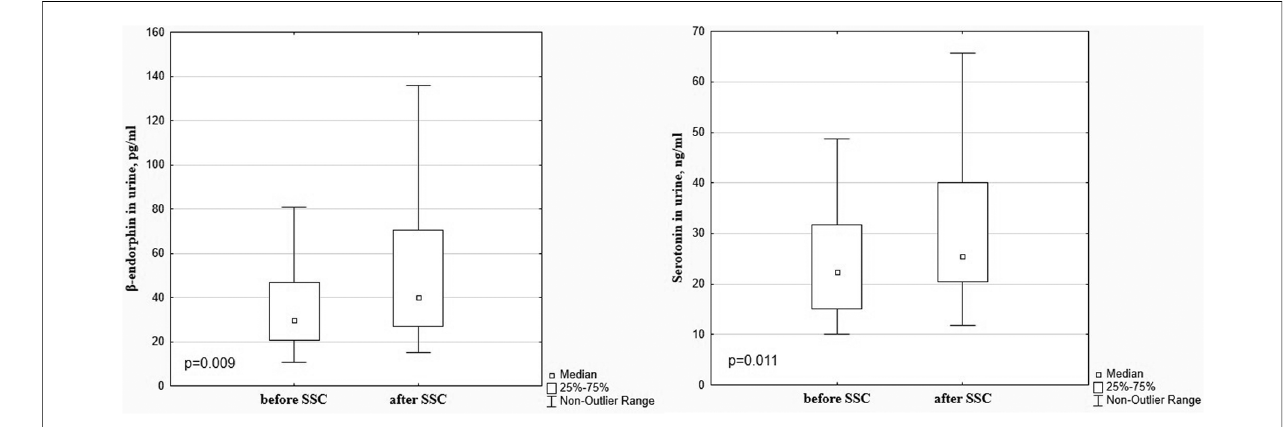
FIGURE 2 β -Endorphin and serotonin in the urine in preterm infants before and after